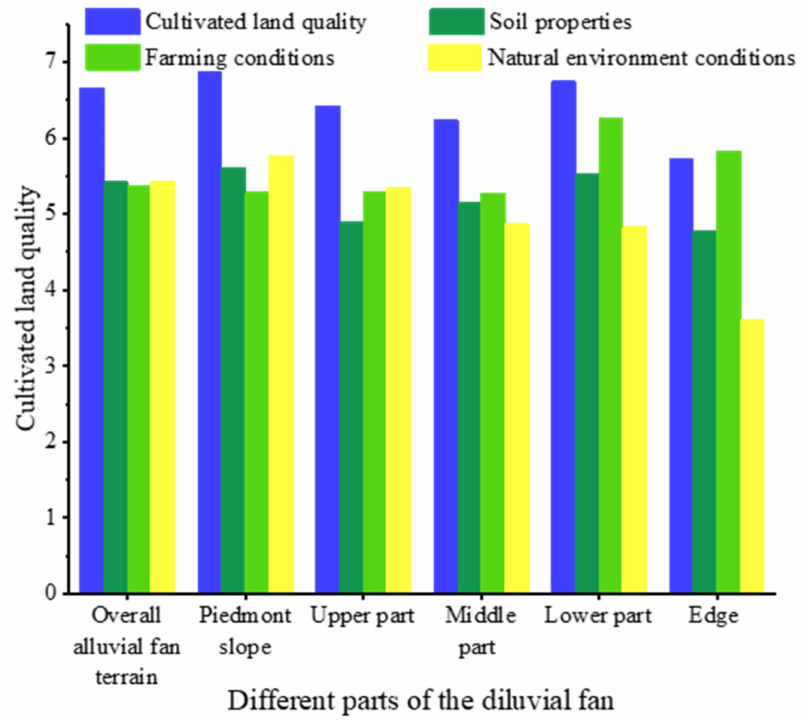
Figure 11. Cultivated land quality of each part of the diluvial fan and the average rank of three dimensions.